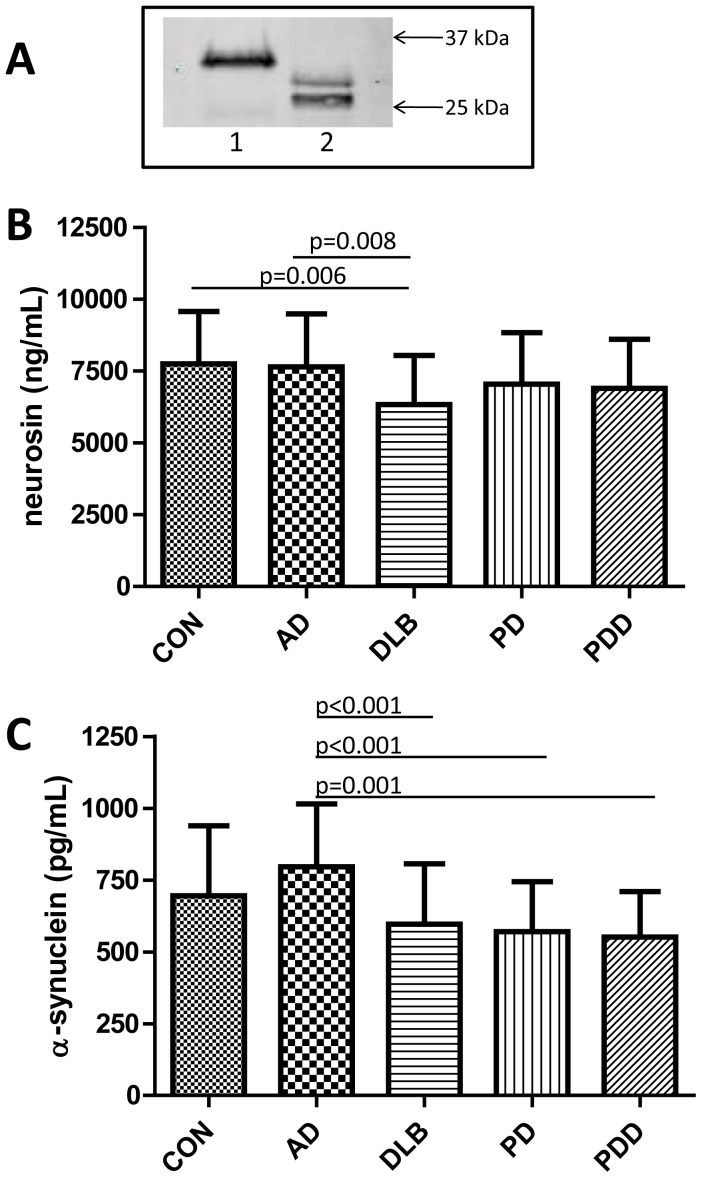
Specificity of the biotinylated goat anti-human neurosin antibody used in the neurosin ELISA was evaluated by western blotting (A).Lane 1 recombinant human neurosin, lane 2 immunoprecipitated neurosin from pooled human CSF. CSF concentrations of neurosin (B) and α-synuclein (C). Significant differences are indicated by p-values generated by use of ANCOVA group comparisons with correction for age or ANOVA followed by Bonferroni posthoc testing.